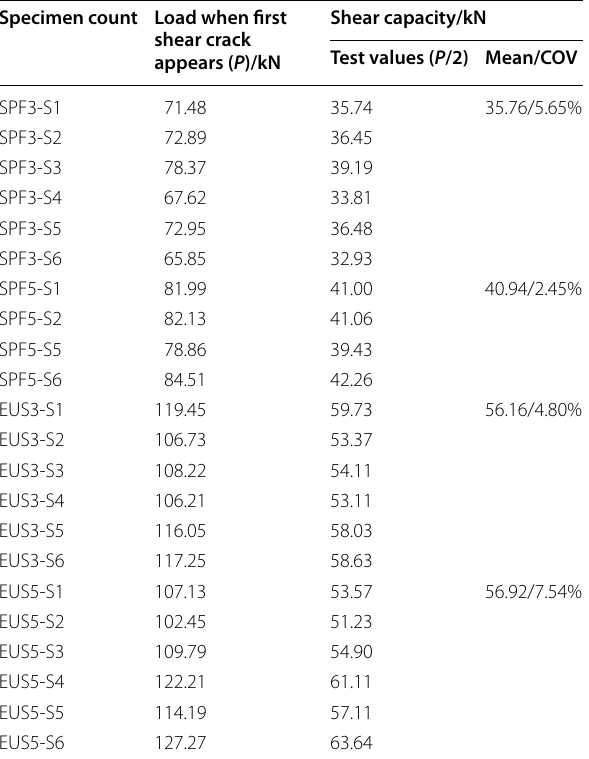
Table 3 Test results of the rolling shear capacities of SPF and EUS CLT